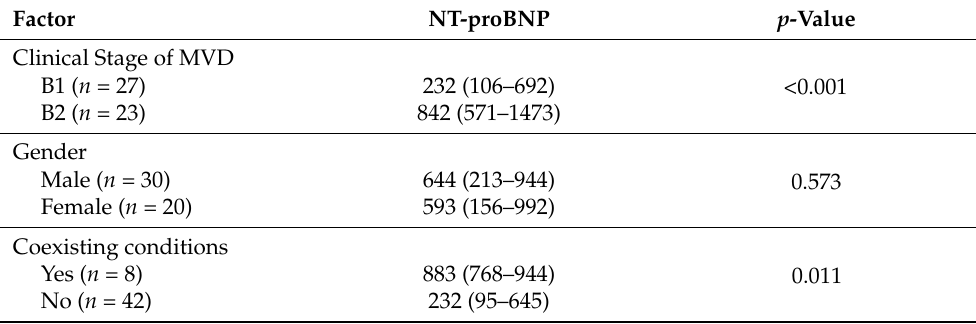
Table 3. Descriptive statistics (median and interquartile range) with the results of the corresponding testing (Mann–Whitney) for different factors affecting the concentration of NT-proBNPin stage B1 and B2 dogs. (NT-proBNP: N-terminal-prohormone-B-type natriuretic peptide, MVD: Mitral Valve